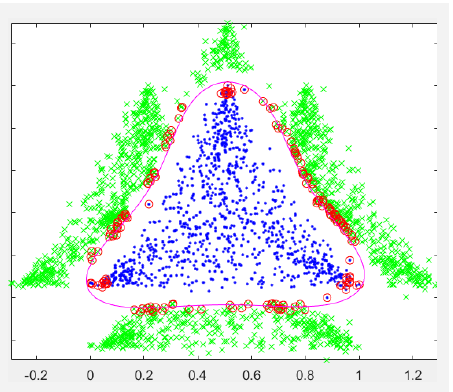
Figure 2. The set of tight‑wrapping points and tight‑wrapping surfaces of feature domains. The blue points represent the positive sample, the green points represent the negative sample, and the red circles are support